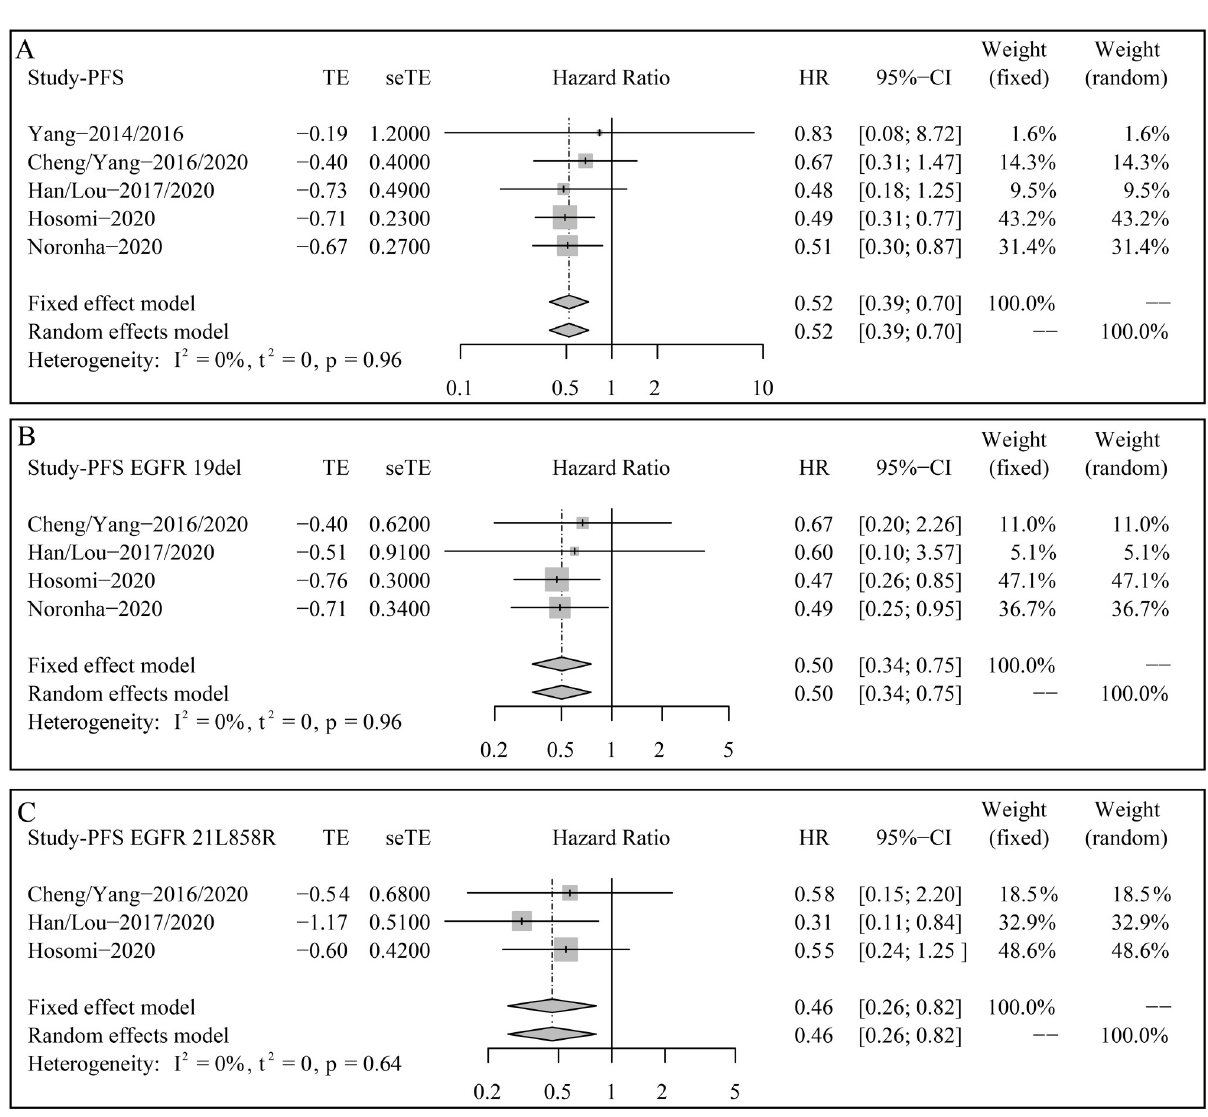
Fig 3. Forest plots of progression-free survival (PFS) for hazard ratios (HRs). (A) Total enrolled patients; (B) Patients with EGFR exon 19 deletion; (C) Patients with EGFR exon 21 L858R.